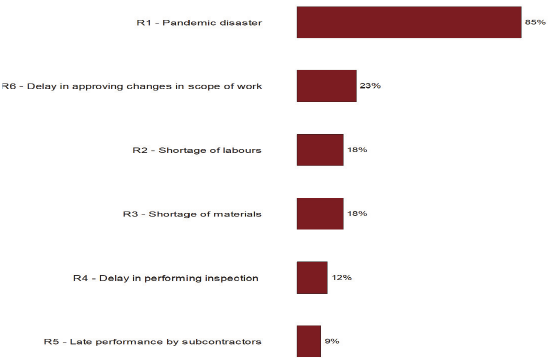
Fig. 3. Schedule Sensitivity Tornado Graph